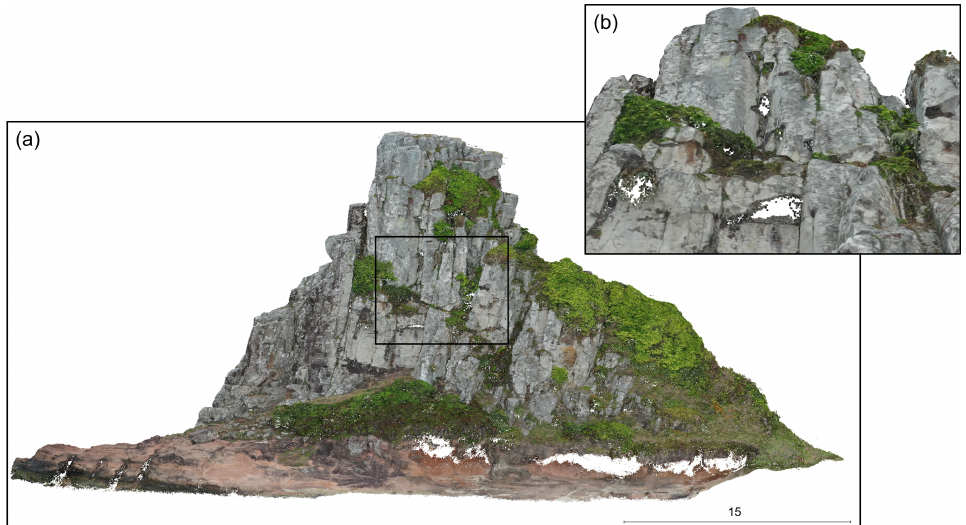
Figure 5. Dense point cloud from Torre da Guarita generated by UAV survey. ( a ) The bottom part presents many gaps (white “holes”) indicating a lack of photogrametric information. These areas correspond to subvertical features, common in outcrops. ( b ) Details show many subvertical regions of the tower with no point